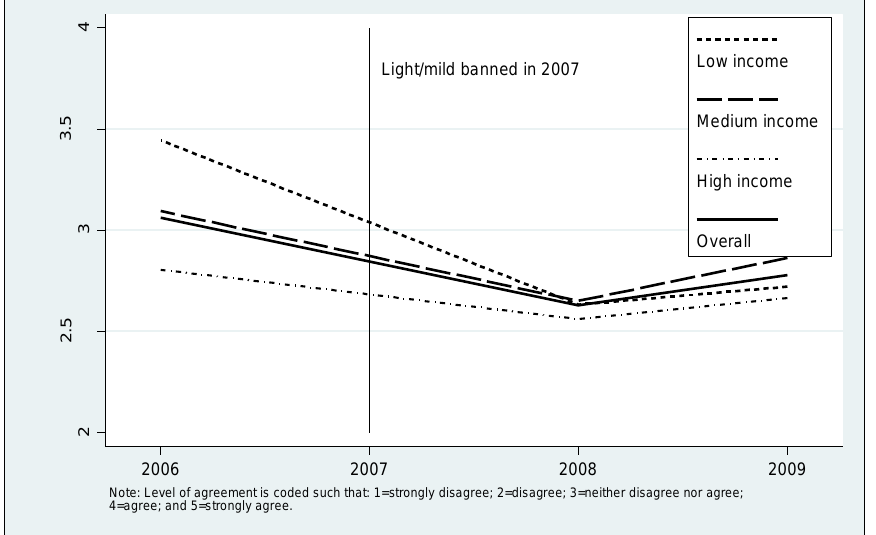
Figure 2. Mean of endorsement of ‗Light cigarettes are less harmful‘ by income.